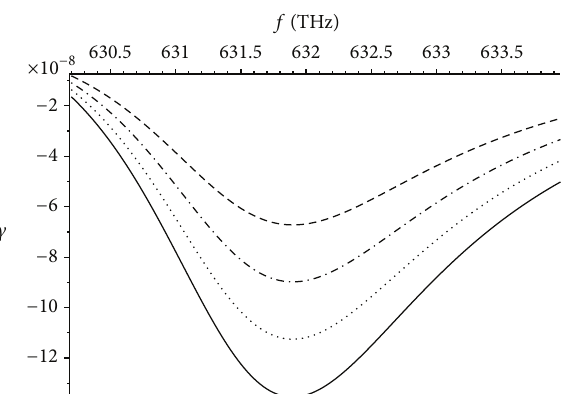
Figure 4: The imaginary part of the effective refractive index (the extinction coefficient), 𝛾 , versus the frequency for different dielectric core thicknesses. The core thicknesses are 30nm (dashed), 40 nm (dot-dashed), 50nm (dotted), and 60nm (solid).